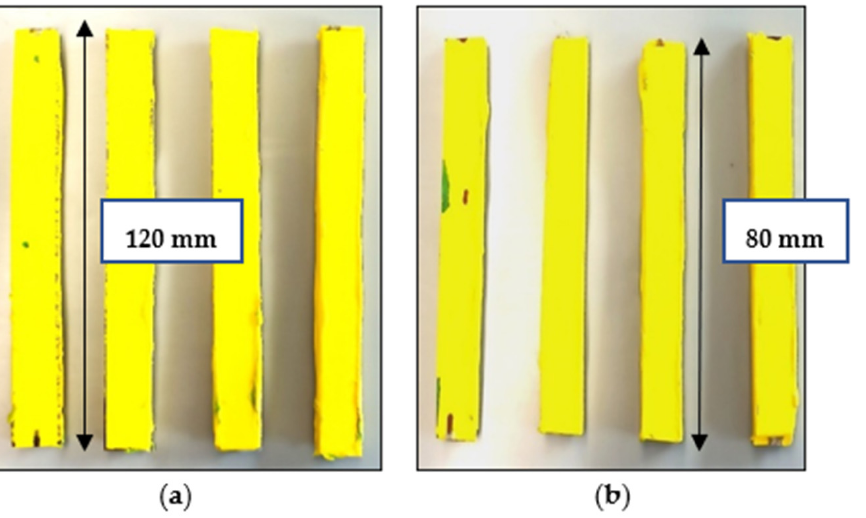
Figure 4. Compression molded samples with axially aligned fibers: ( a ) for tensile test, and ( b ) for Charpy test.